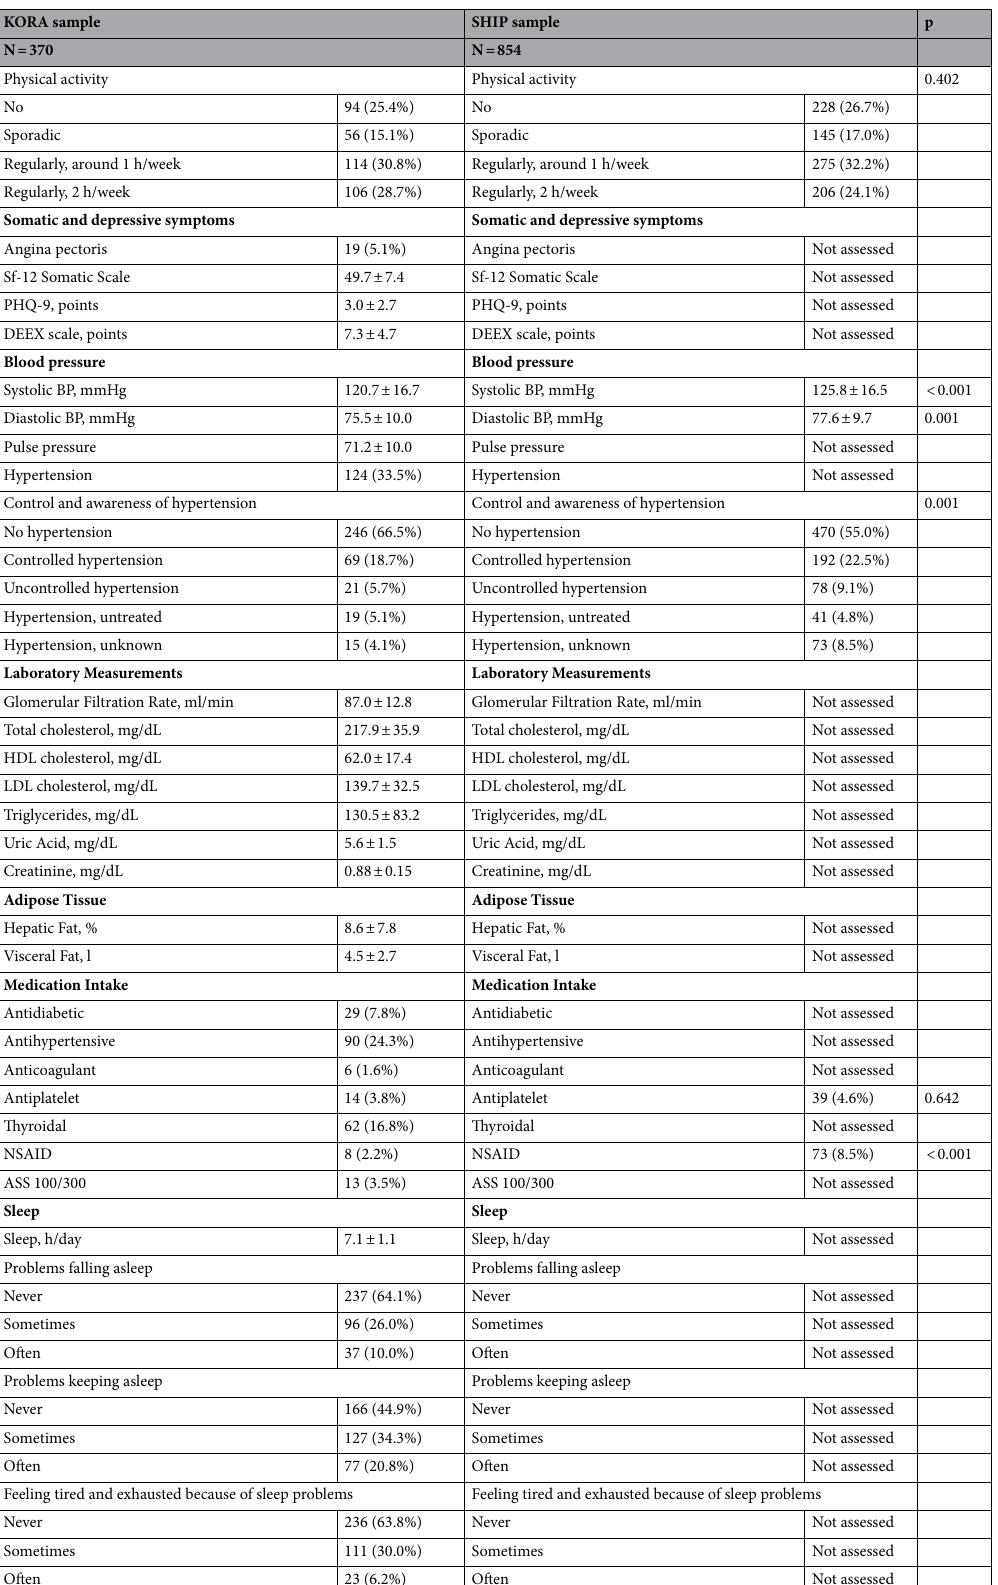
Table 1. Description of predictor covariates for the KORA sample and SHIP sample. Continuous variables are presented as arithmetic means with standard deviation or medians with 1st and 3rd quartile. Categorical variables are presented as counts and percentages. P-values from t-test, Kruskal–Wallis test or χ 2-test, where